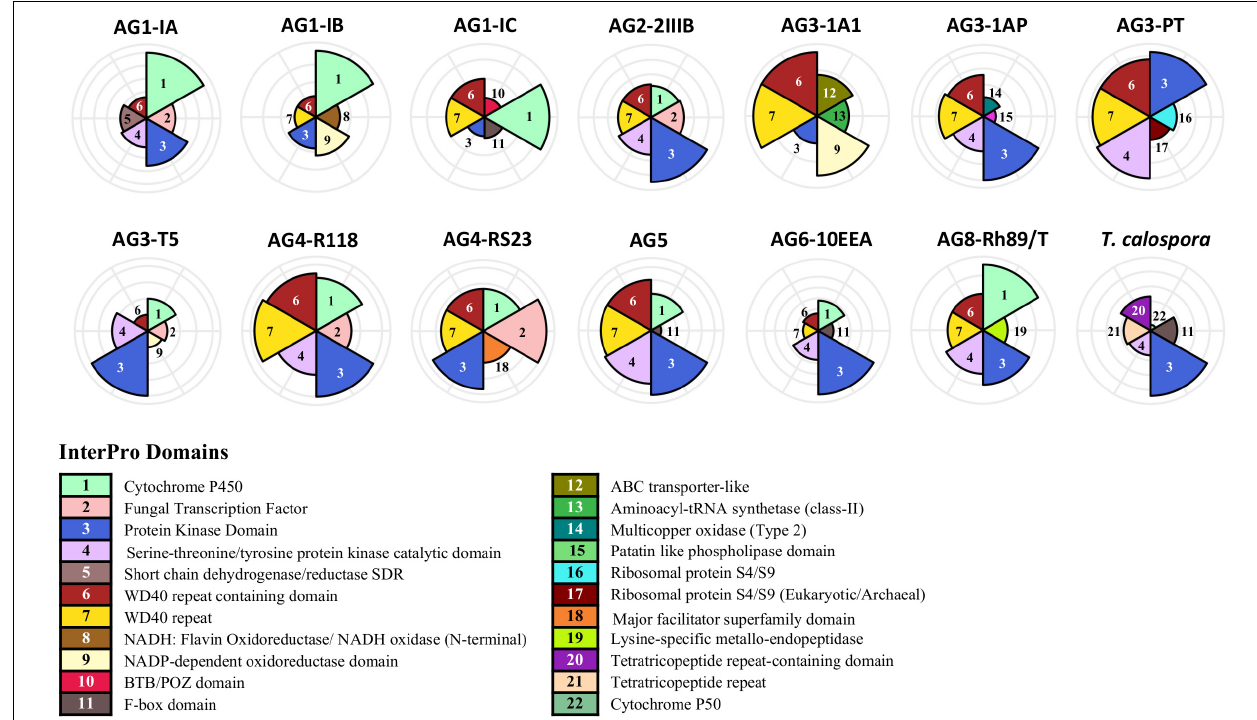
FIGURE 3 | InterPro domain analysis of the unique proteome. In the unique proteome of each fungal isolate, InterPro protein domain families were predicted using InterProScan (Version 5.45–80.0). Only the top five most enriched protein families are shown. The number marks the corresponding annotation of InterPro family domain in the circular bar